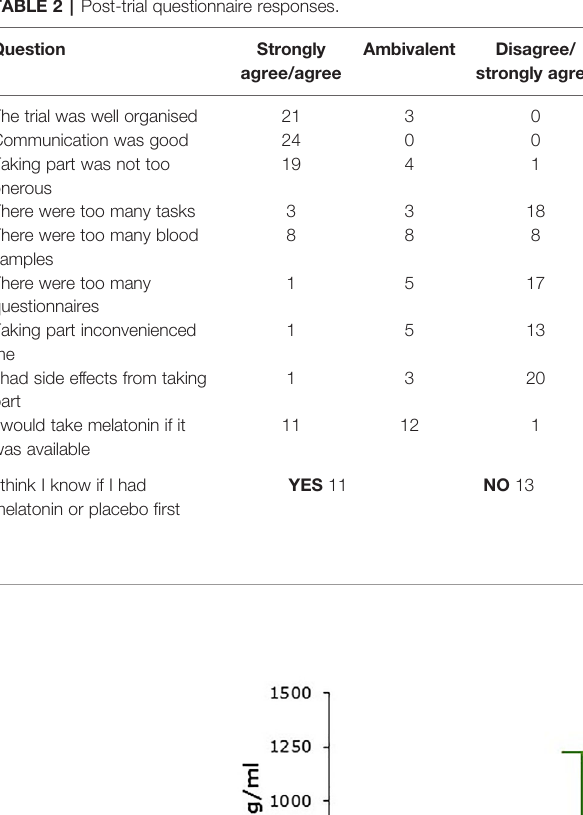
TABLE 2 | Post-trial questionnaire responses.